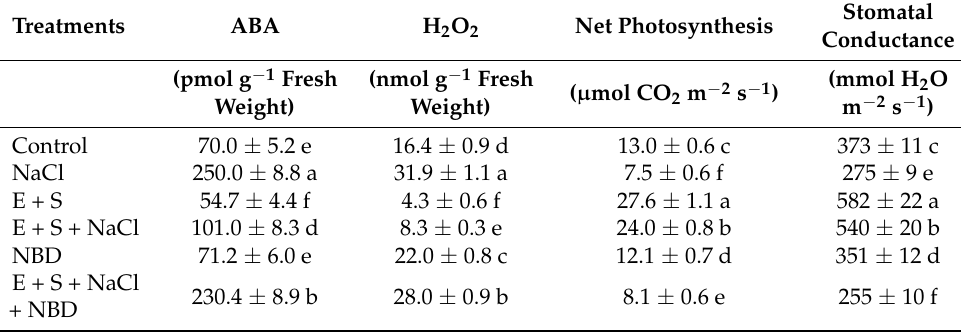
Table 6. Content of ABA, H 2 O 2 , net photosynthesis, and stomatal conductance in mustard leaves at 30 days after sowing. Plants were treated with 200 µ L L − 1 ethephon (E) and 200 mg S kg − 1 soil (S) in presence or absence of 100 mM NaCl. The treatment with 100 µ M norbornadiene (NBD) was applied either alone or with combination of 200 µ L L − 1 ethephon (E) and 200 mg S kg − 1 soil (S) with 100 mM NaCl. Data are presented as means ± SE ( n = 4). Data followed by same letter are not significantly different by LSD test at ( p < 0.05). E, ethephon; NBD, norbornadiene; S,